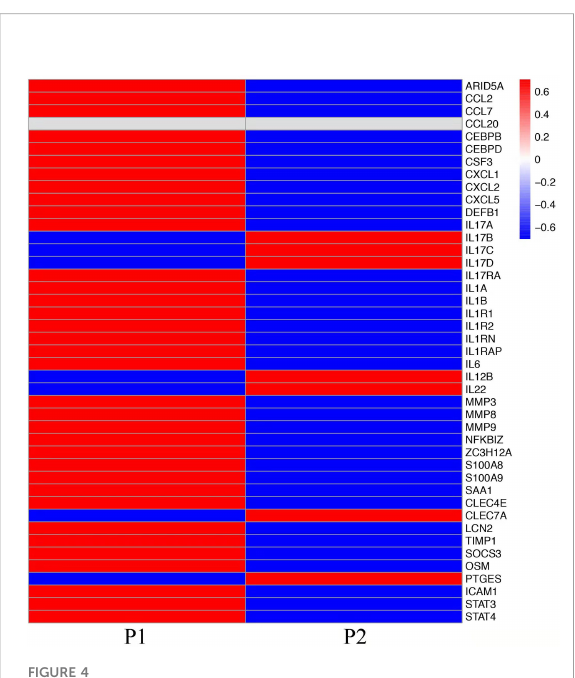
FIGURE 4 Comparative transcriptome sequencing in these two patients. Heatmap showed the transcript viabilities of antifungal immunity-related genes. Red represented high viability and blue represented low